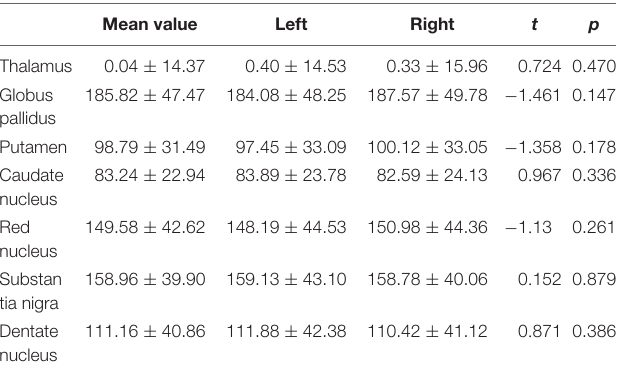
TABLE 2 | Comparison of the susceptibility values of the gray matter nuclei between the left and right hemispheres (mean ± SD). Mean value Left Right